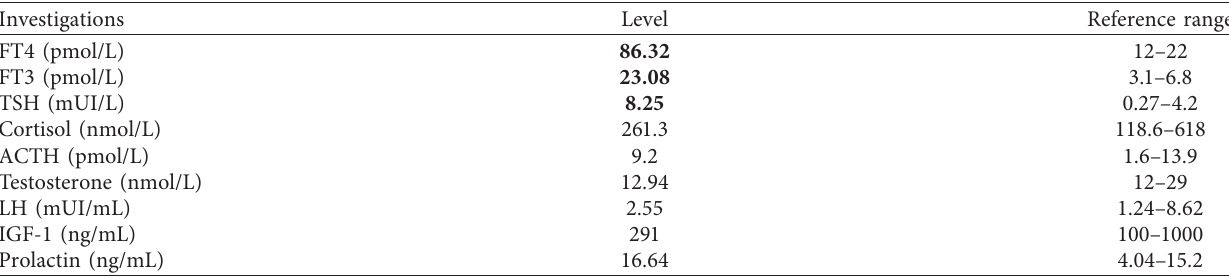
Table 1: Hormonal